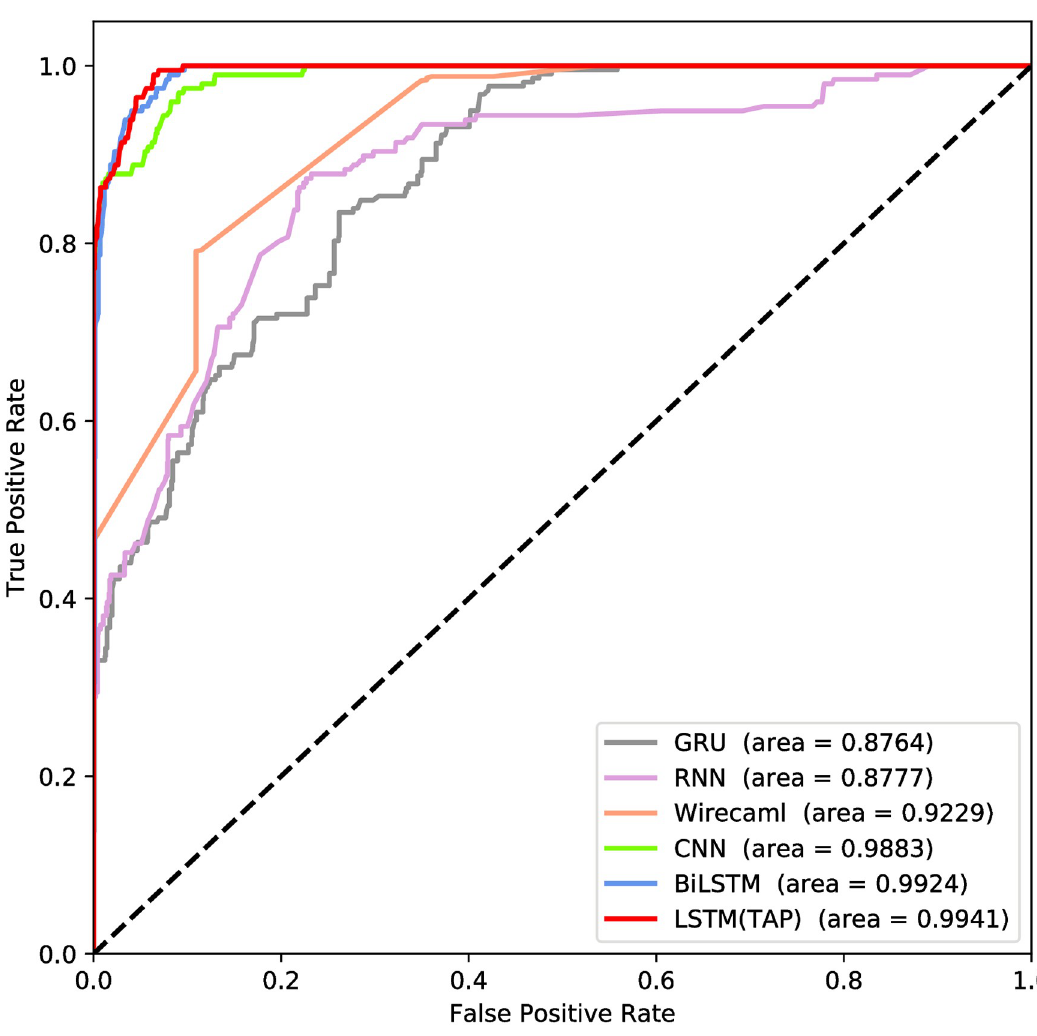
Fig 8. ROC comparison of binary classification model.